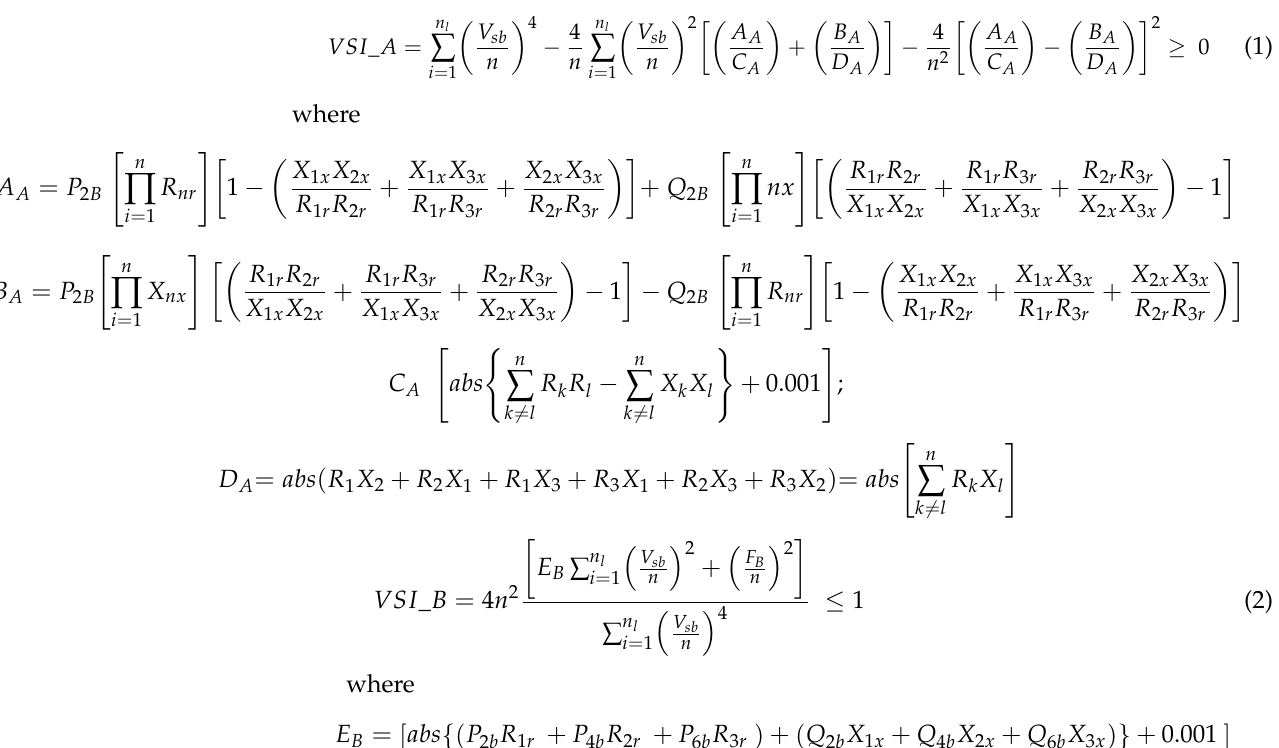
Figure 1. Electrical equivalent diagram of the mesh distribution network [40–42]. In the stage 1, VSAIs in [40,41] are designated as VSI_A and VSI_B . Both aim at optimal asset sitting. The threshold value of VSI_A , expression shown in Equation (1), lies between 0 (instability) and 1 (stable). The expression of VSI_B , as illustrated in Equation (2), has a threshold value, unlike VSI_A , between 1 (instability) and 0 (stable). The VSI_D in Equation (3) must exhibit a positive value, and the numerical value based on the highest deviation shows the critical loading condition of a bus/node in a distribution network close to the voltage